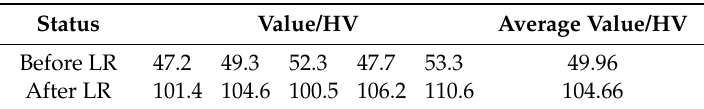
Table 2. Hardness of cold sprayed Al coating before and after LR.